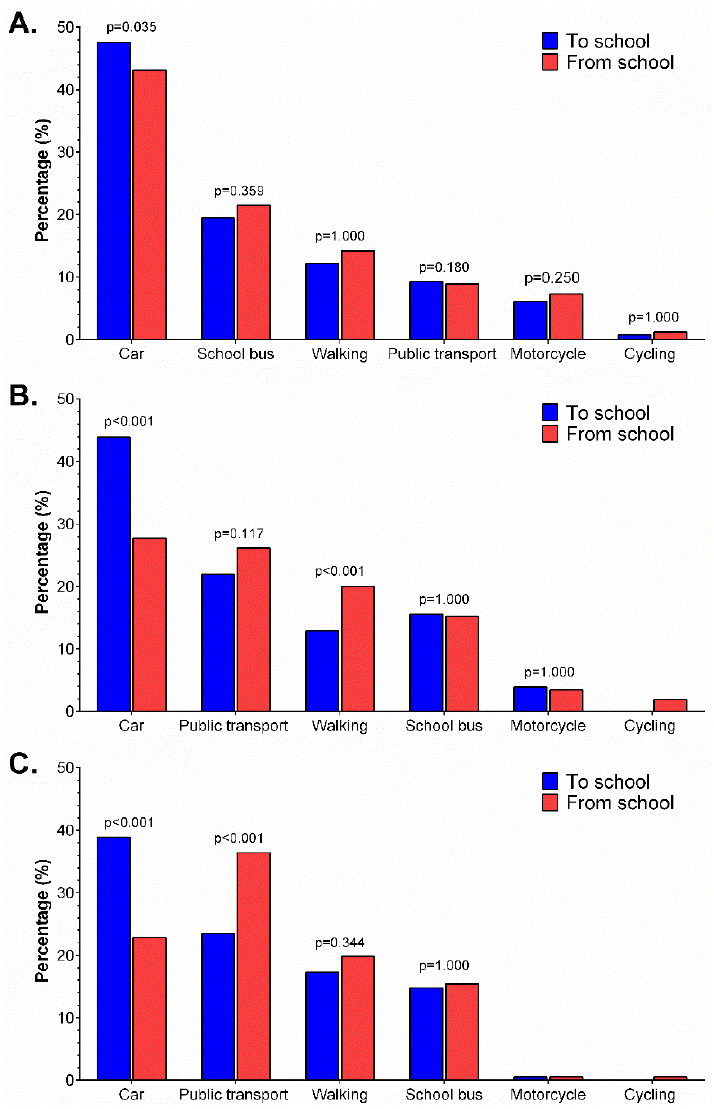
Figure 2. Modes of commuting to and from school according to age groups. A. Children, B. Young Adolescents and C. Older Adolescents